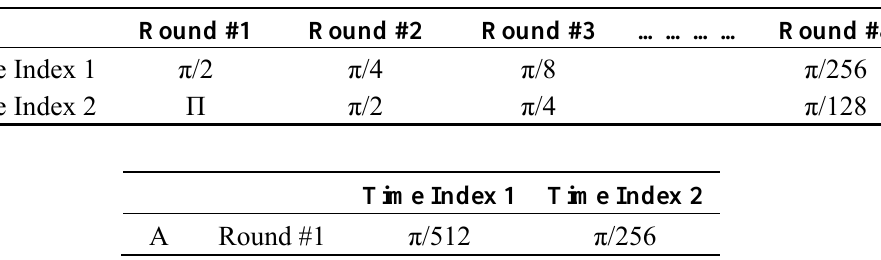
Table 1. SIN Circular Table